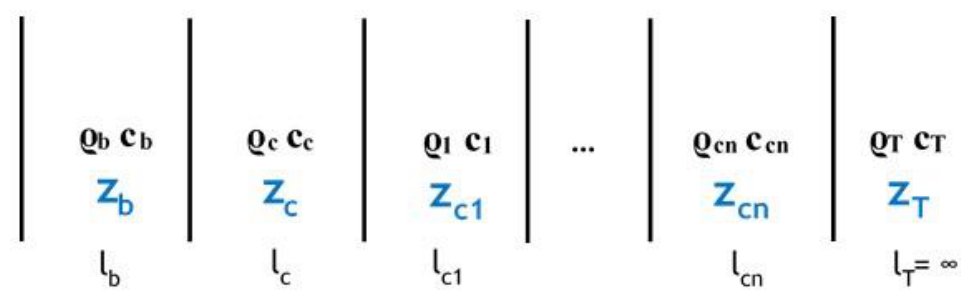
Figure 1. Model of a piezoceramic transducer with multicomponent matching layers.